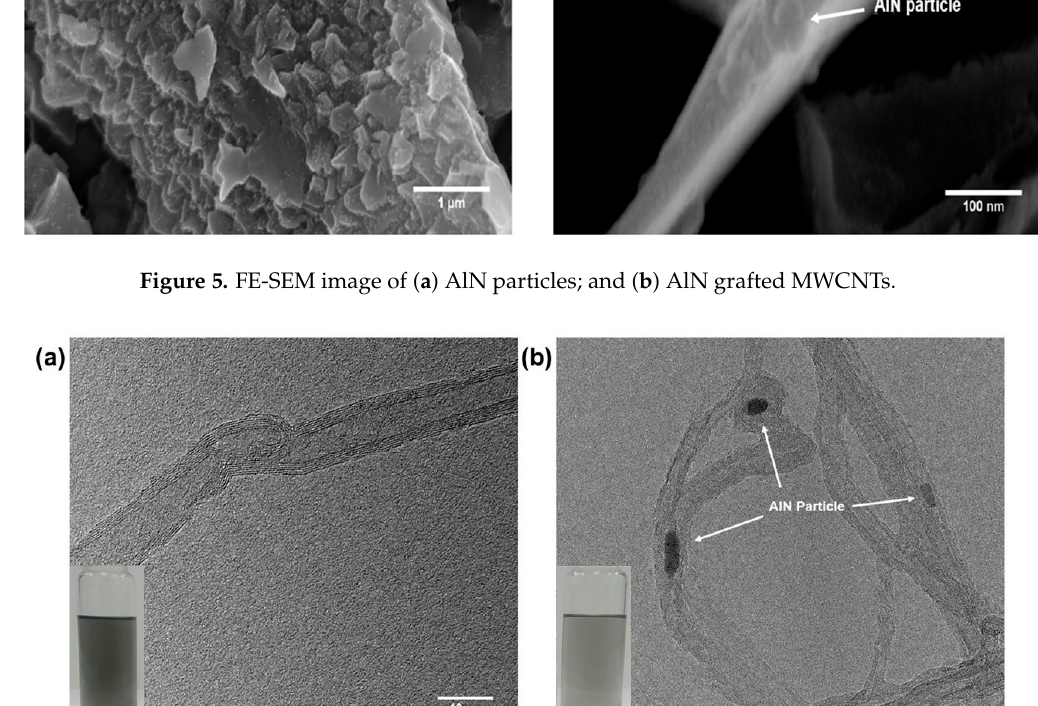
Figure 5. FE-SEM image of ( a ) AlN particles; and ( b ) AlN grafted MWCNTs.